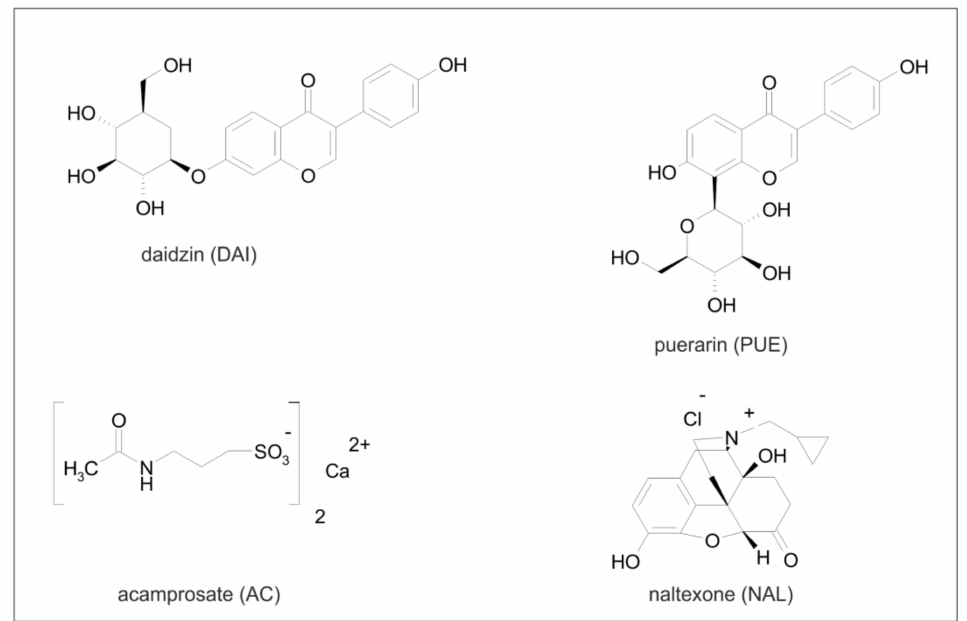
Figure 1. Chemical structures of the main kudzu flavonoids—DAI and PUE (used in this work), and classic drugs that inhibit the drinking reflex (AC, NAL).